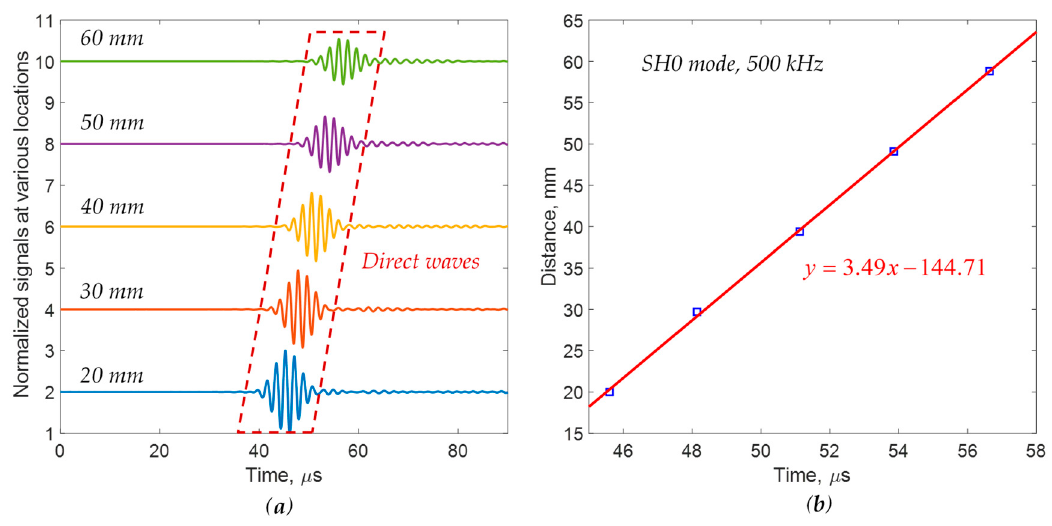
Figure 19. Experimental group velocity measurements for the SH0 mode excitation at 500 kHz on a 3-mm quasi-isotropic composite plate: ( a ) waveforms; ( b ) correlation between distance and TOF.